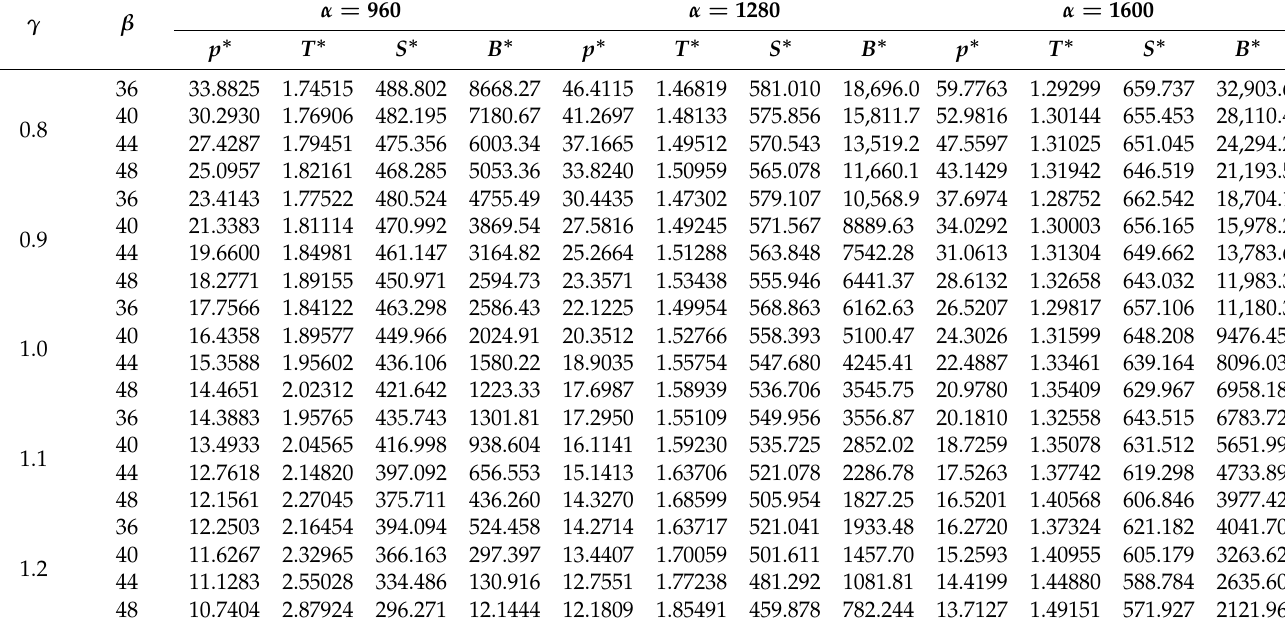
Table 4. Sensitivity of the optimal policy ( p ∗ , T ∗ , S ∗ ) and the maximum profit B ∗ to variations of the parameters α , β and γ when n =